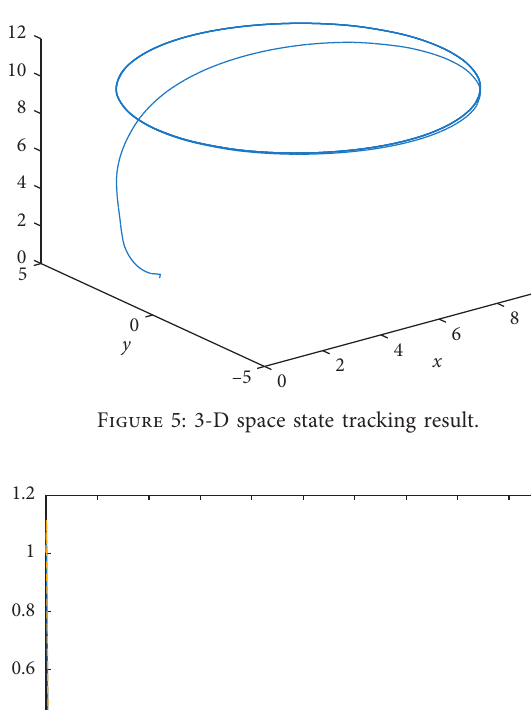
e d , and error z .